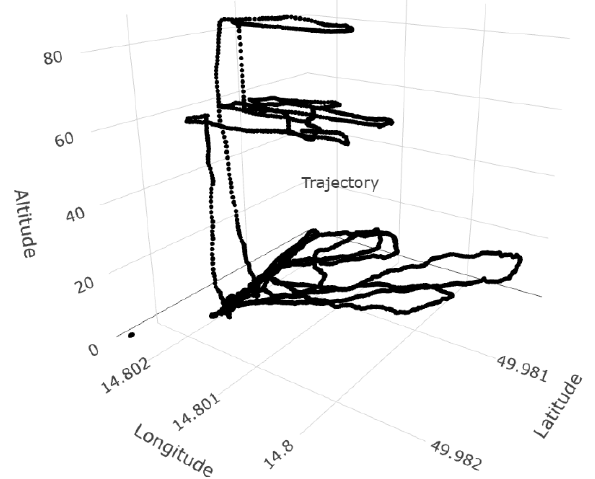
Figure 5. The trajectory of the sensor’s measurements. The measurement was first carried out on the ground level and then by an unmanned aerial vehicle—first; we descended just above the treetops (approx. 60 m), then we made a short flight at the height of 80 m.